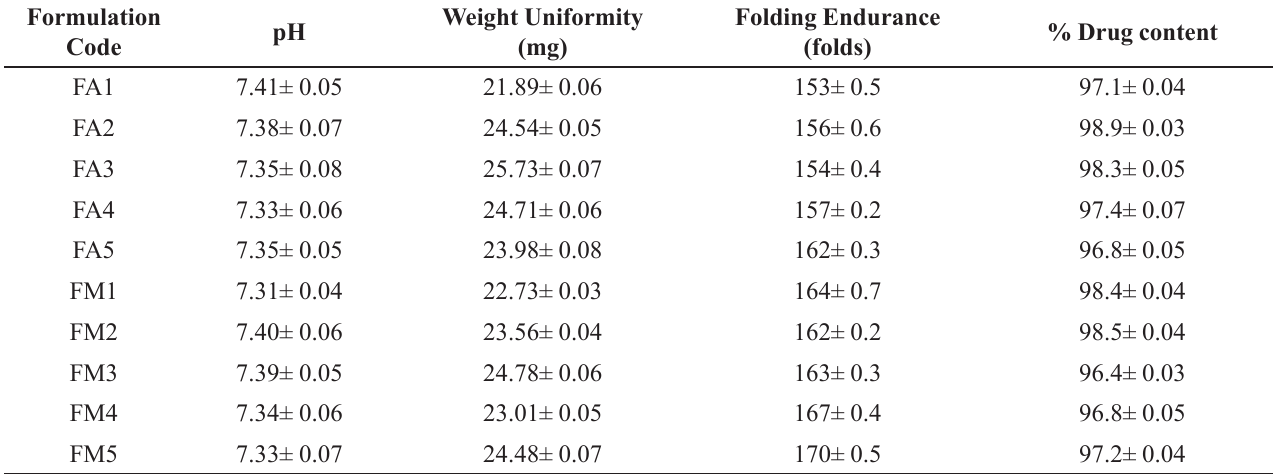
TABLE IV - The pH, weight, folding endurance and percent of drug content in Aripiprazole loaded flexy film formulations